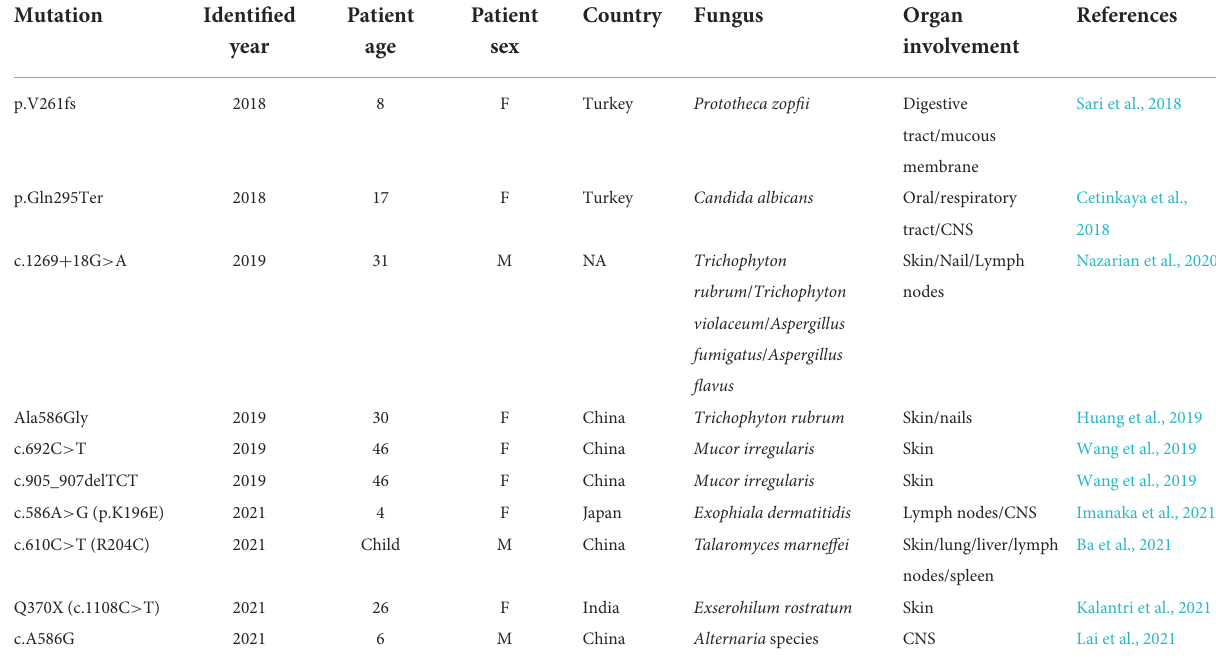
TABLE 1 New mutations of CARD9 over the past 4